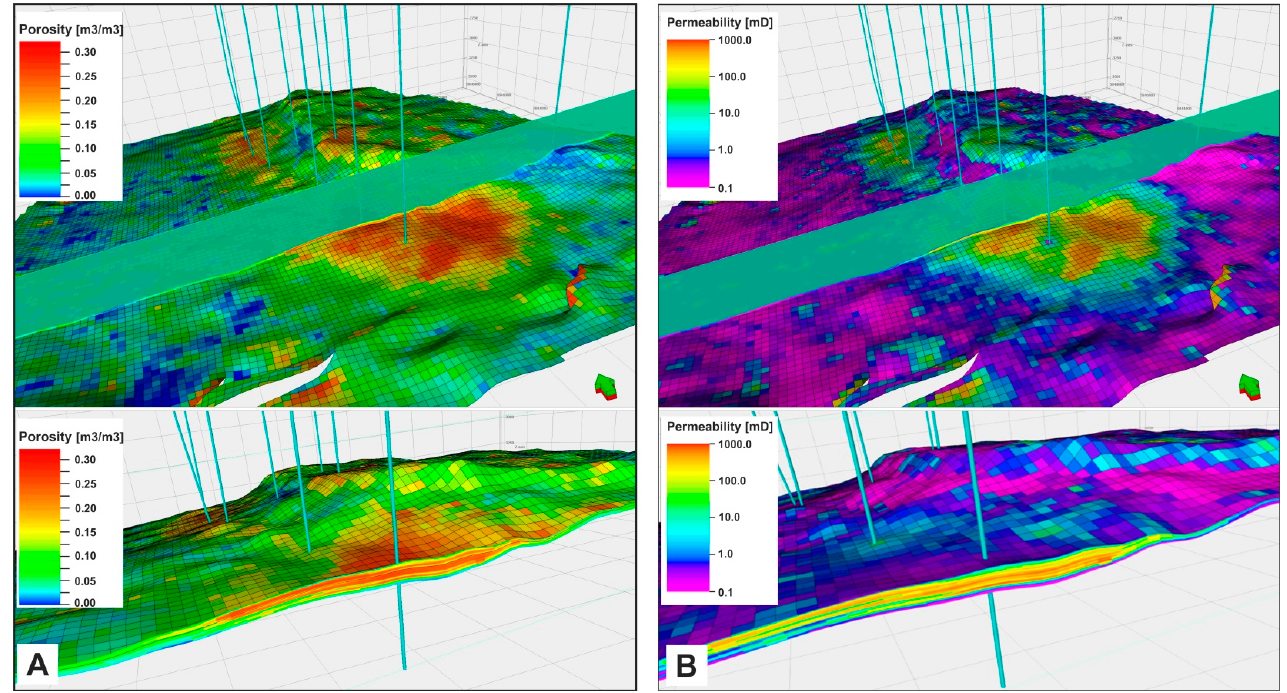
Figure 5. Visualization of the distribution of: ( A )—porosity and ( B )—permeability within the Ca2 main dolomite along the cross-sections of the central part of the 3D model within the target reservoir.